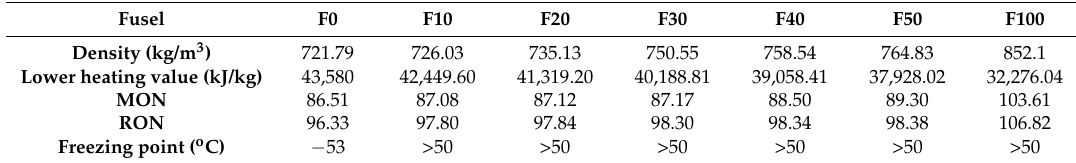
Table 2. Characteristics of the experiment fuels.